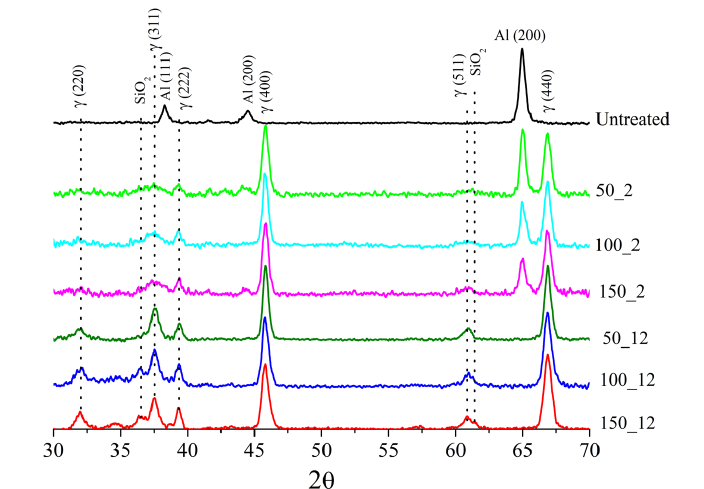
Figure 9. XRD pattern of the PEO samples using grazing incidence of